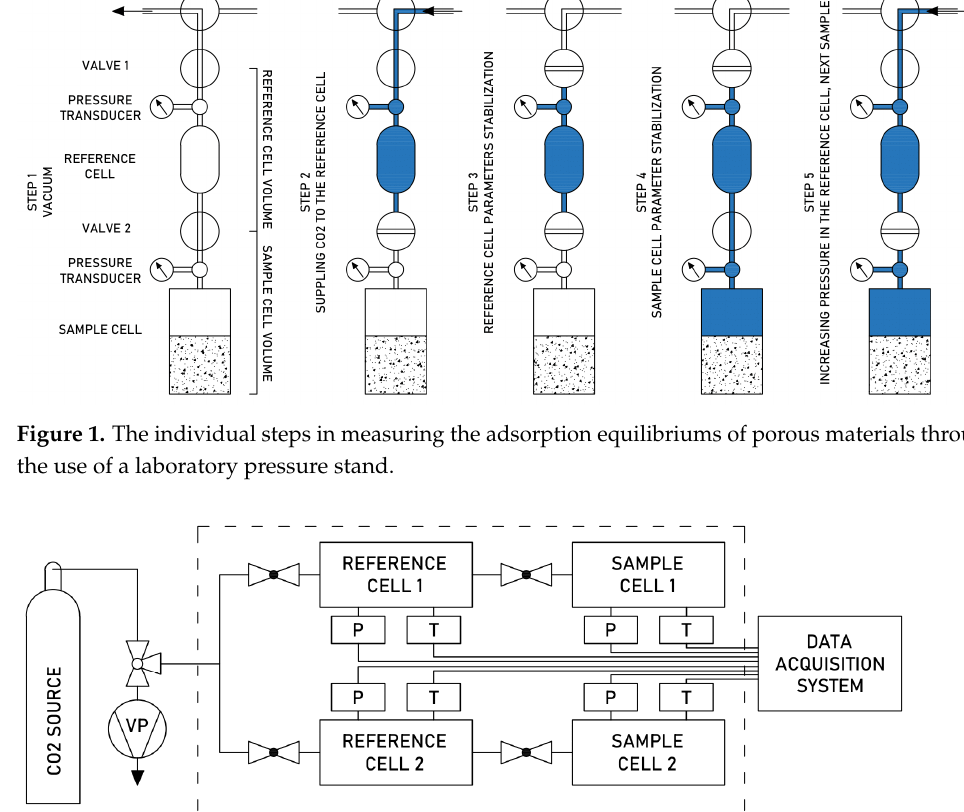
Table 2. The values of adsorption isotherm parameters according to the Freundlich, Langmuir, Jovanovi ć , Temkin, and Hill models.